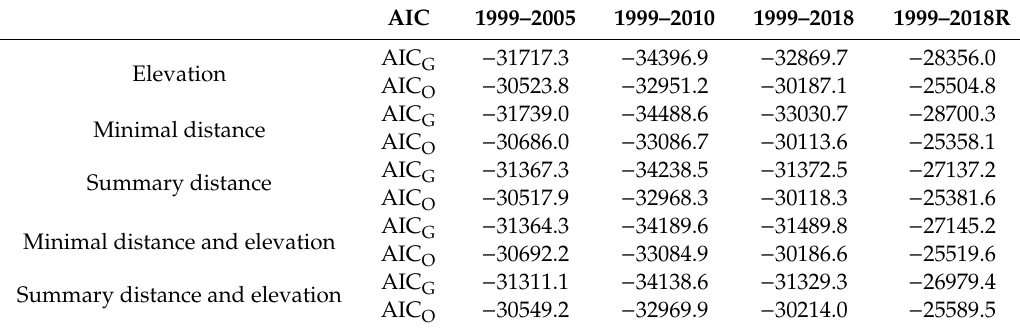
Table 3. Comparison of Akaike information criterion (AIC) from GWR and OLS